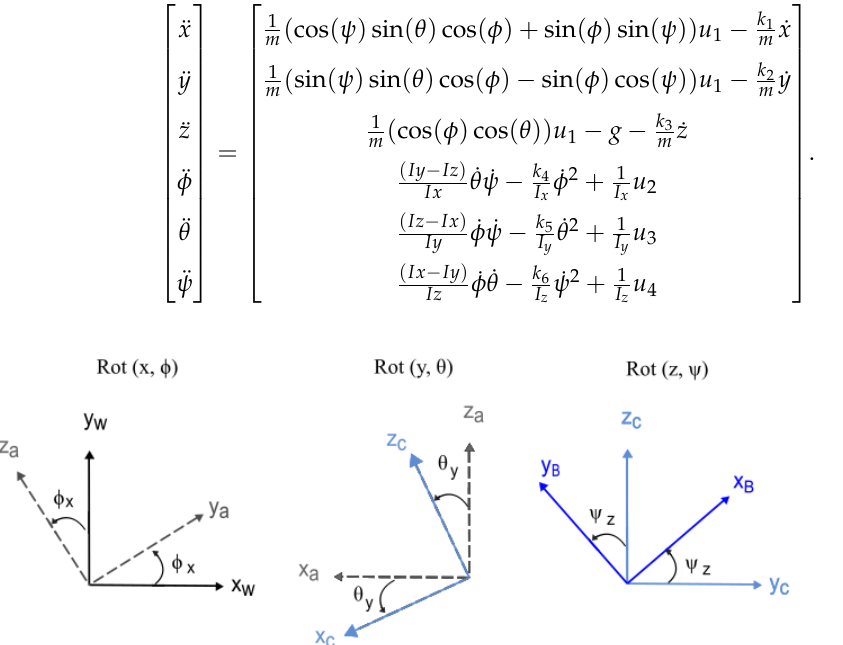
Figure 2. Order of rotations from W to B .